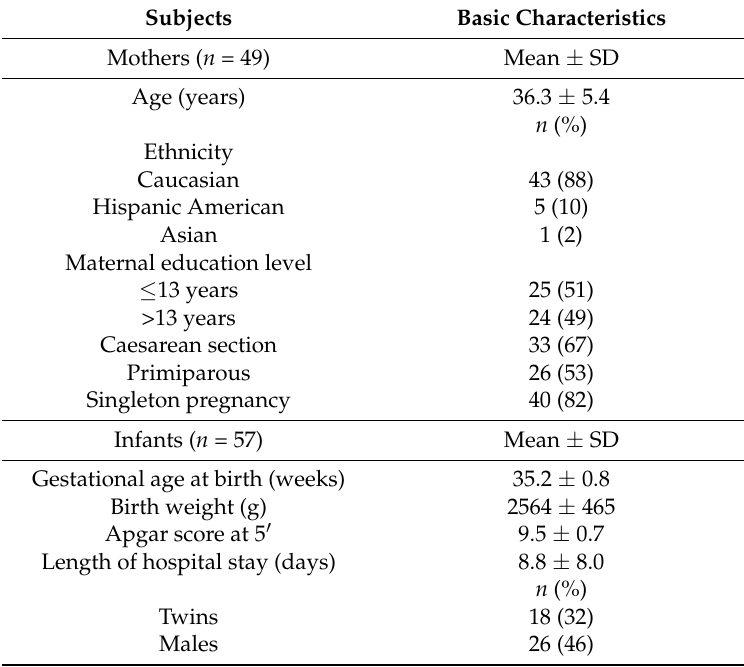
Table 1. Basic characteristics of the mother-infant pairs that have completed the